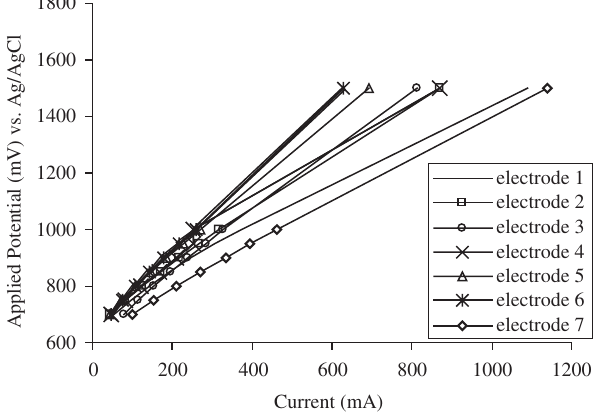
Figure 1. Plot of applied potential vs. current of aged composite electrodes.